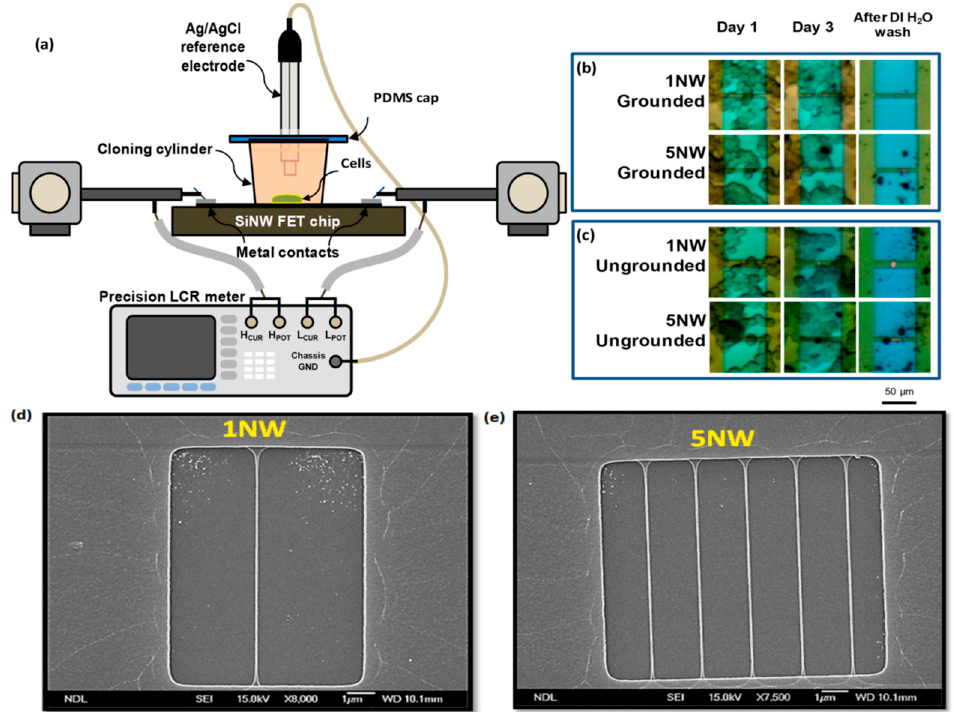
Figure 4. ( a ) Impedance measurement setup for monitoring cell-coupled p-type SiNW FET devices with the reference electrode was connected to the chassis ground of the LCR meter. Microscopy images of cell coupled on 1NW and 5NW FET devices with grounded and ungrounded setups on days 1 and 3 of culture and after DI water wash were shown in ( b ) and ( c ), respectively. Accordingly, SEM images of 1NW and 5NW FET devices are shown in ( d ) and ( e ). Reprinted with permission from [80]. Copyright (2022) Elsevier.